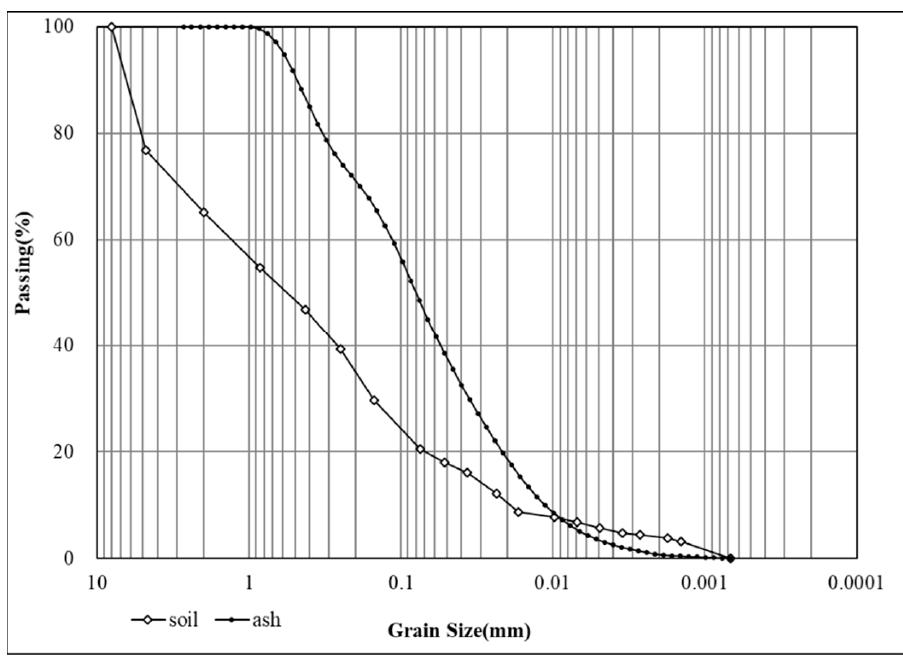
Figure 2. Particle distribution of soil and ash.